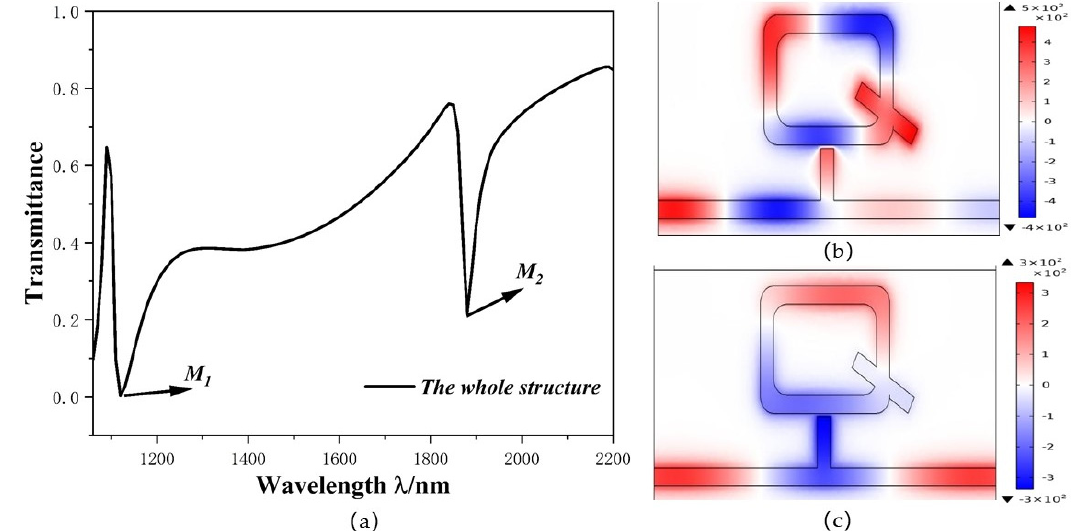
Figure 3. ( a ) Transmission spectra; ( b , c ) Diagram of the normalized magnetic field distribution at λ = 1110 nm and λ = 1880 nm, respectively.